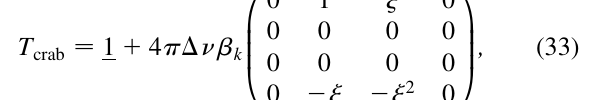
FIG. 7. (Color) Unstable region caused by a crab cavity